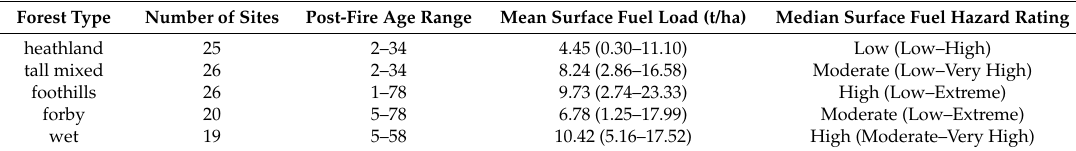
Table 1. Summary of sampling sites and results across the five forest types for destructively sampled fuel loads (Mean fuel load) and the visual fuel hazard rating (Median fuel hazard rating). Values in brackets represent the range of sampled